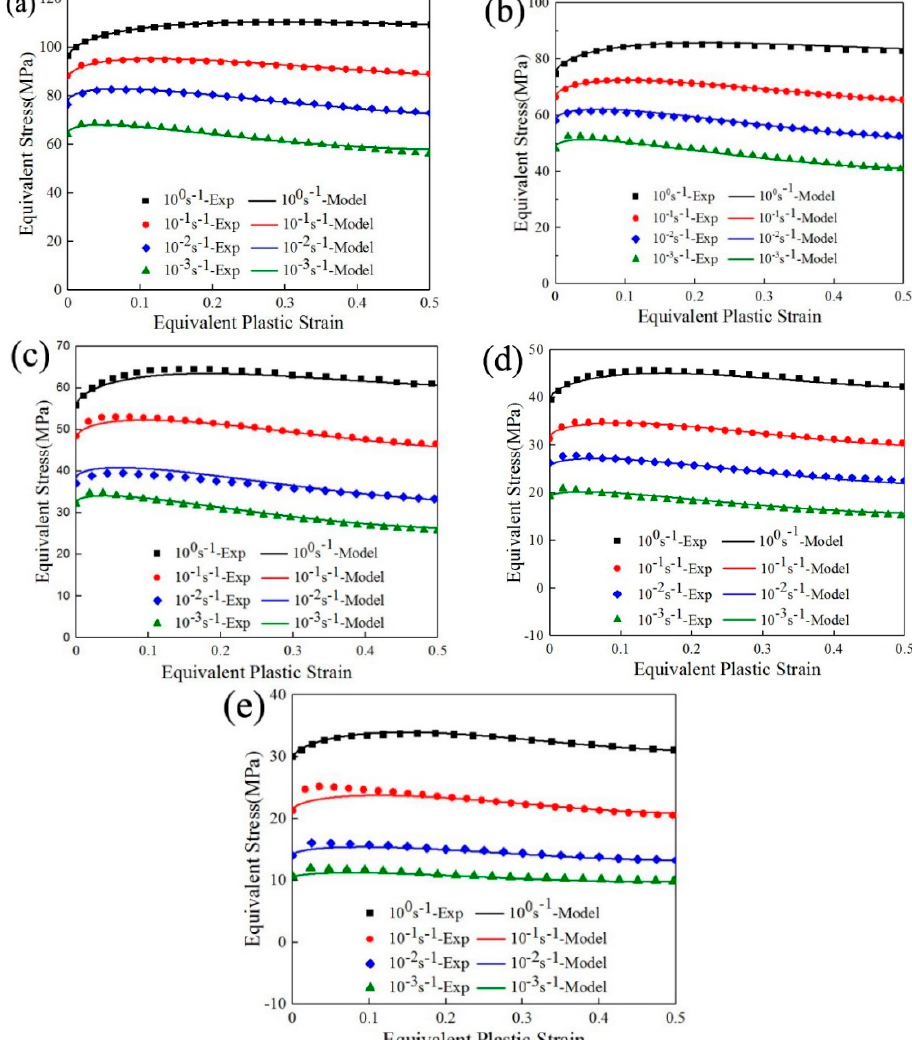
Figure 8. Comparison between the measured data and calculated data by the modified Johnson ‐ Cook (J ‐ C) model ( a ) 573 K; ( b ) 623 K; ( c ) 673 K; ( d ) 723 K and ( e ) 773 K. (J-C) model ( a ) 573 K; ( b ) 623 K; ( c ) 673 K; ( d ) 723 K and ( e ) 773